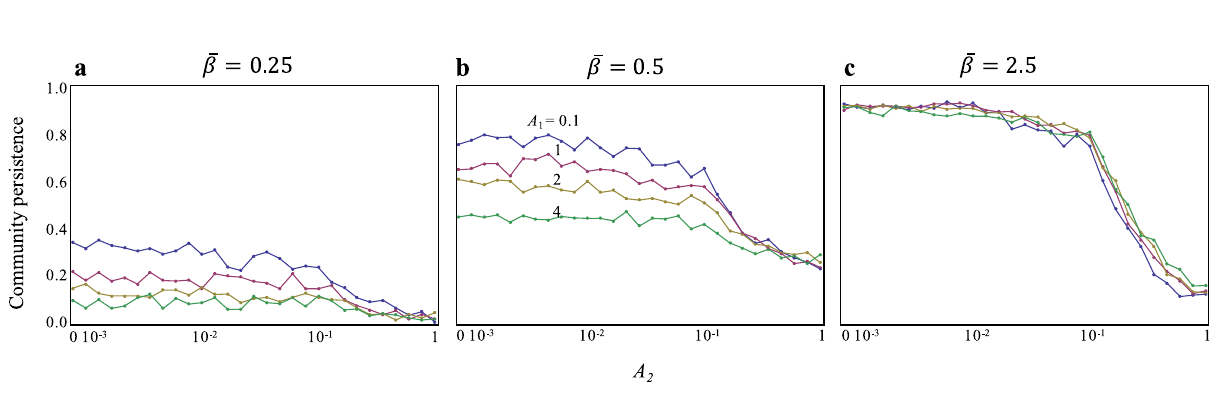
Figure 3. Effects of interaction strengths on community stability with varying infection rates. ( a ) β = 0.25. ( b ) β = 0.5. ( c ) β = 2.5. Color represents values of A 1 . Other information is identical to that in Fig.